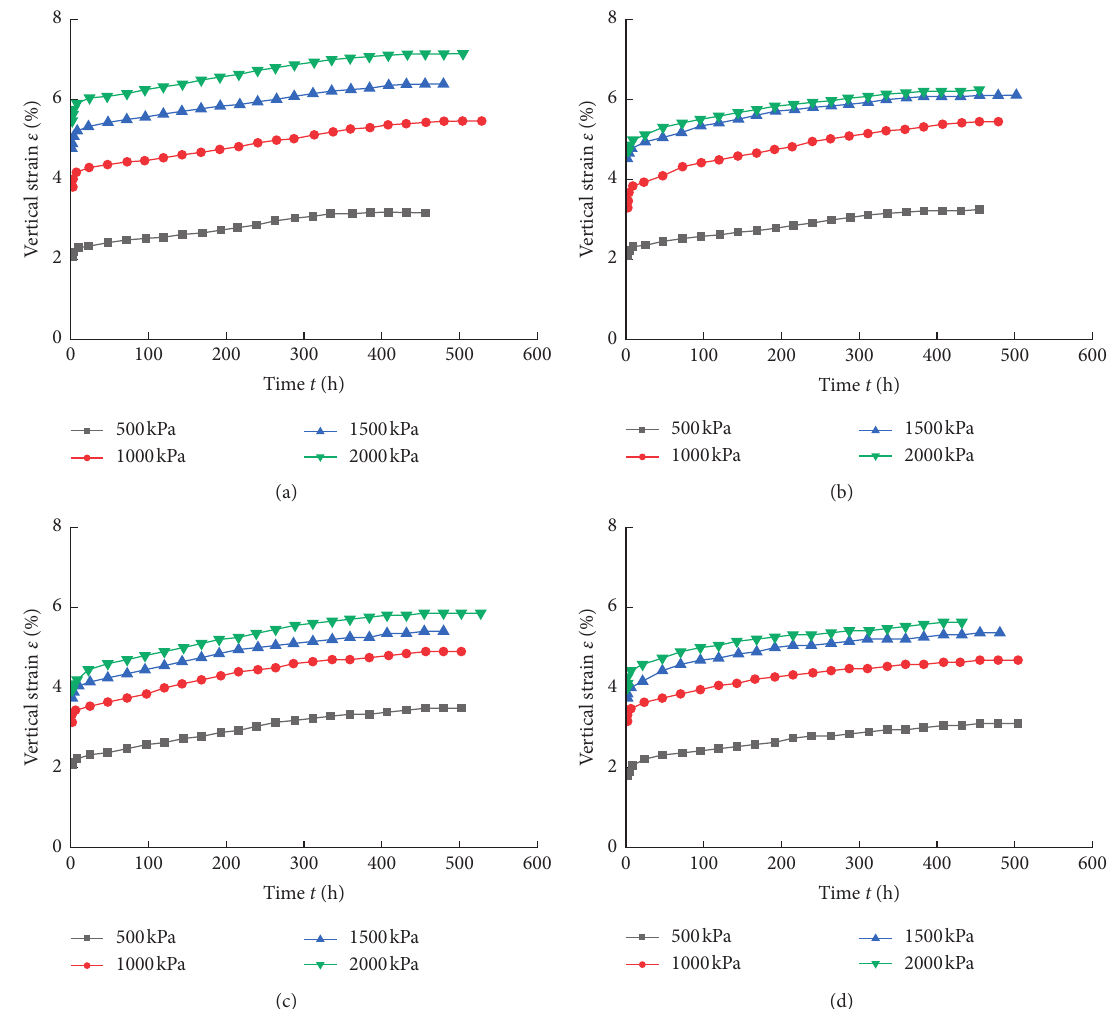
Figure 2: Strain-time curve with different compaction energies and vertical stress. (a) E (d) E 3 � 2169.0kJ/m 3